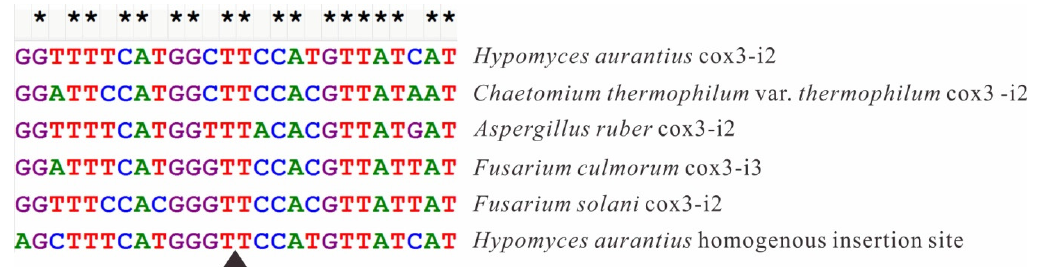
Figure 7. Comparison of 13 ‐ bp sequences upstream and downstream of insertion sites. Flanking sequences of cox3 ‐ i2 in H. aurantius were compared to best hits of the following ORFs: cox3 ‐ i2 in C. thermophilum var . thermophilum , cox3 ‐ i2 in Aspergillusruber CBS 135680, cox3 ‐ i3 in Fusarium culmorum strain CBS 139512, and cox3 ‐ i2 in F. solani , and the deduced later ‐ inserted intron of cox3 ‐ i2 in H. aurantius was evaluated. Probable insertion site was shown by triangle; letters A, T, C, and G were shown by the color of green, red, blue, and brown, respectively. Asterisks represent base pairs are same in corresponding position. Sequences were aligned using Clustal W in MEGA 6.0.